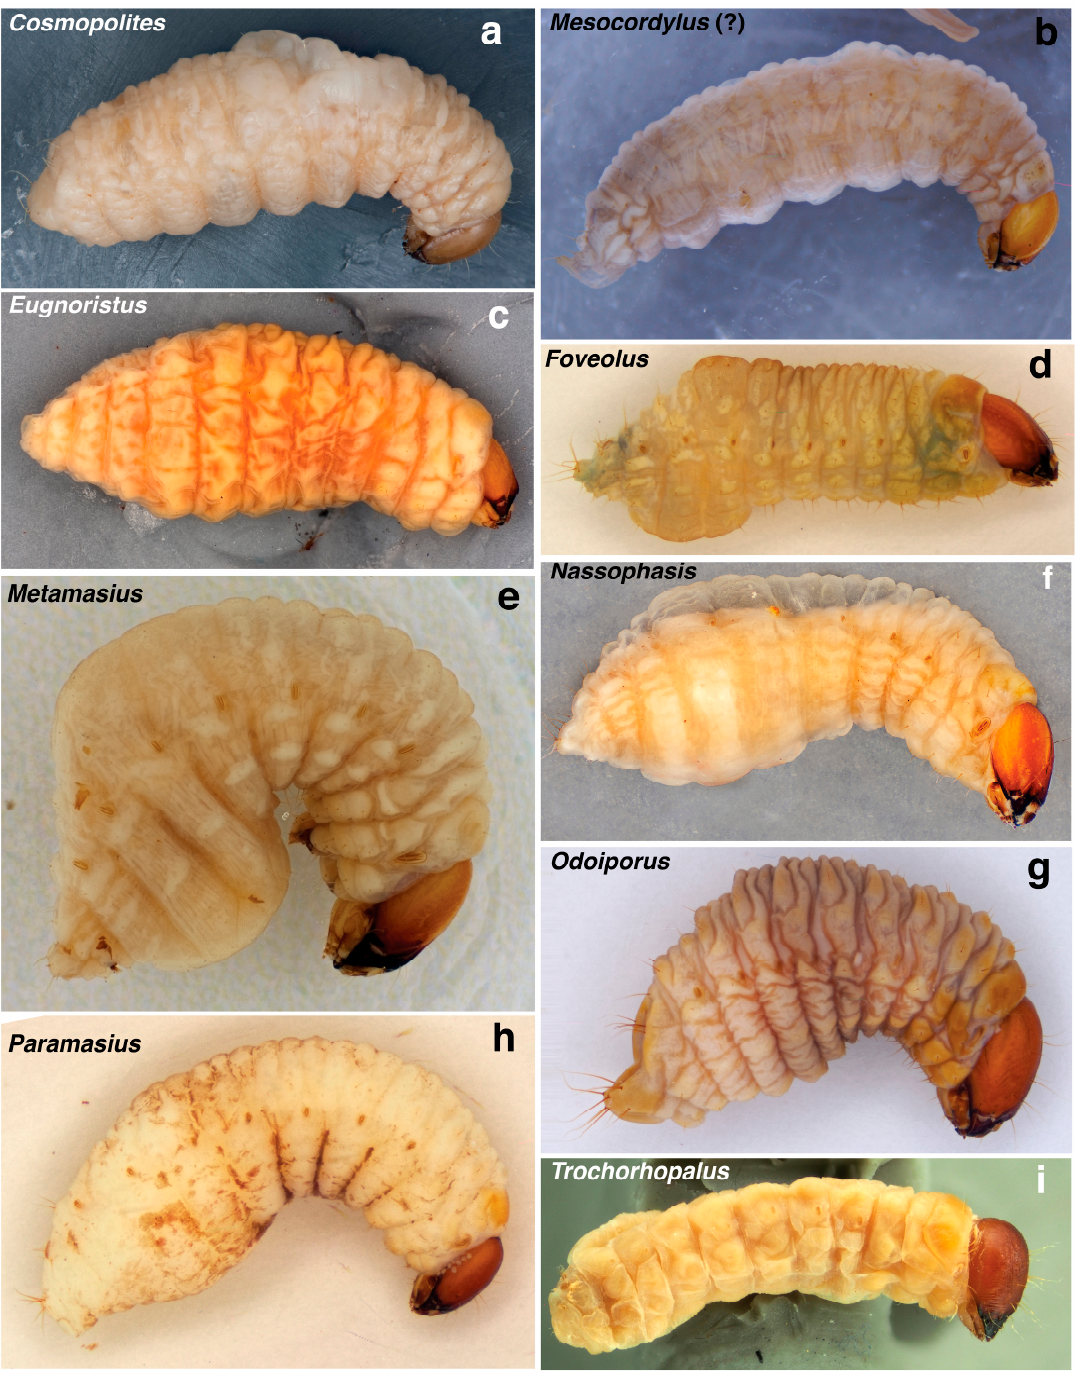
Figure 3. Larva, lateral view: ( a ) Cosmopolites ; ( b ) Mesocordylus (probably); ( c ) Eugnoristus ; ( d ) Foveolus ; ( e ) Metamasius ; ( f ) Nassophasis ; ( g ) Odoiporus ; ( h ) Paramasius ; and ( i ) Trochorhopalus .